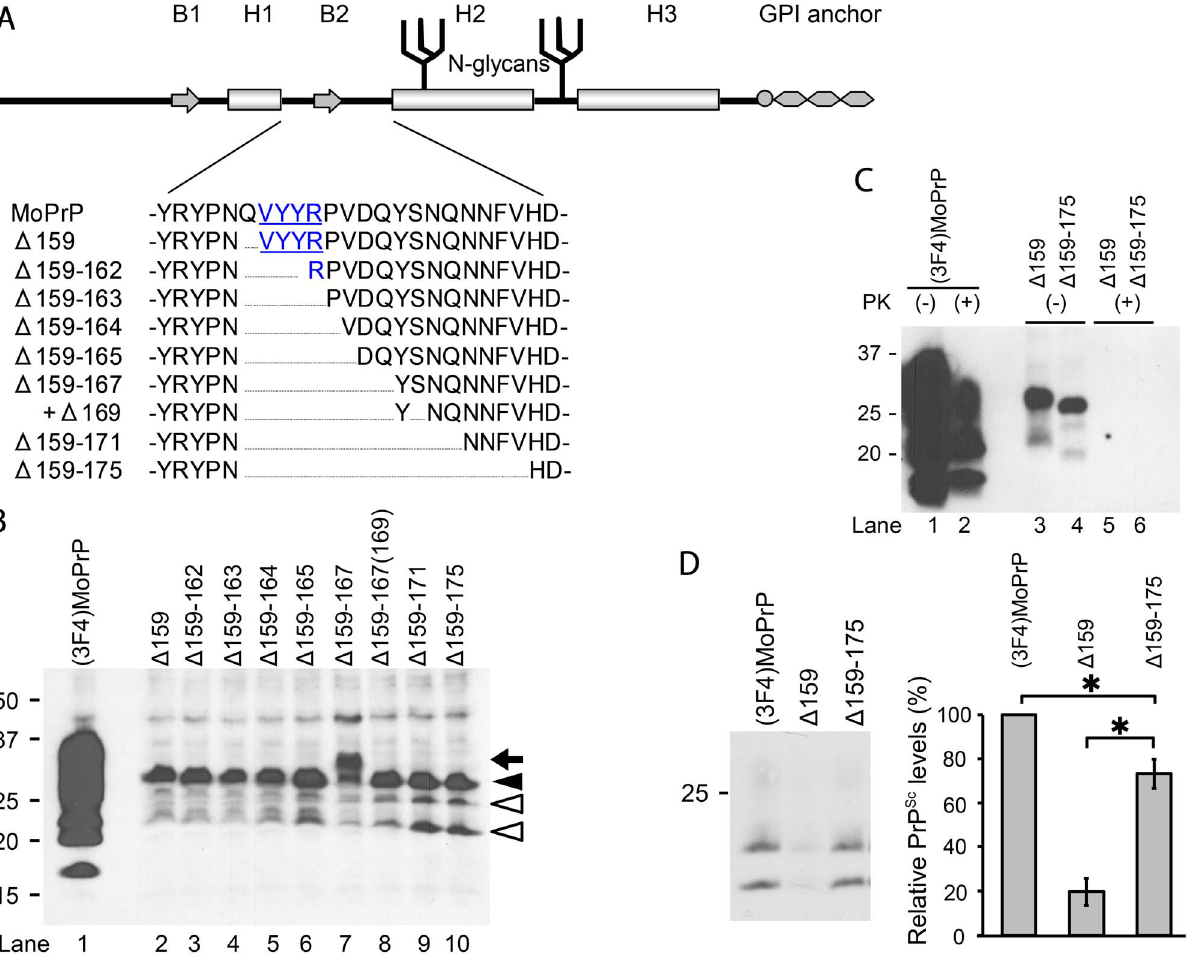
Figure 1. Expression of D PrPs and dominant-negative inhibition (DNI) of D 159 and D 159–175 in persistently prion-infected cells. A. Schematic illustration of prion protein secondary structure elements comprising two b -strands (B1 and B2) and three a -helices (H1–3) and post- translational modifications (two N-linked glycans and glycosylphosphatidylinositol anchor) along with position and extent of deletion of D PrPs constructs. Deletions in the H1 , H2 portion have a common N-terminal end (residue 159) and gradually extend into the C-terminal direction. All constructs have a 3F4 epitope tag (methionines at residue 108 and 111). Underlined residues denote B1. B. Comparison of D PrP expression levels. Representative immunoblot is shown for detection of (3F4)MoPrP and D PrPs in transiently transfected N2a cells using mAb 3F4. D PrPs are similar in expression level glycosylation appearance, except for D 159–167 which has an extra fragment larger than the diglycoform (lane 7, arrow). C. D PrPs are not converted into PK-resistant PrP in prion-infected cells. 22L-ScN2a cells were transiently transfected with (3F4)MoPrP, D 159 or D 159–175, and cell lysates digested with PK or not. Immunoblot was done using mAb 3F4. D. Pilot study for dominant-negative inhibition (DNI) of D 159 and D 159–175. DNI was assessed by co-transfecting 22L-ScN2a cells with (3F4)MoPrP and D 159 or D 159–175, respectively, and testing for PK-resistant (3F4)MoPrP. Left panel shows representative immunoblot (mAb 3F4) and right panel the statistical analysis of quantified PK-res levels of a triplicate experiment. Empty pcDNA3.1 plasmid was used as control for co-transfection in lane 1. The error bars indicate standard deviation. *, p ,